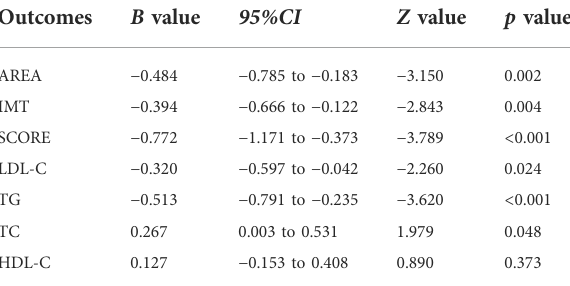
TABLE 9 Effect of dosage on measured ef fi cacy of